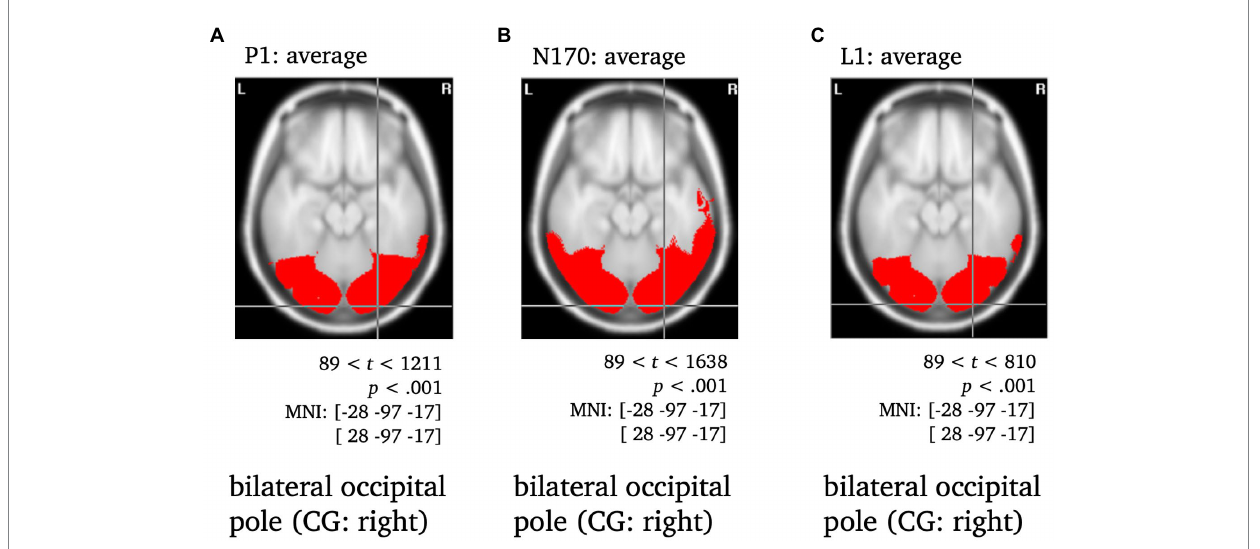
FIGURE 4 Statistically significant sources for the time span of the P1, N170 and L1 averaged across conditions. Statistically significant differences in activity are marked red, with p < 0.001, t crit = 89. Per panel, the center of gravity (CG) is labeled and the respective MNI coordinates are